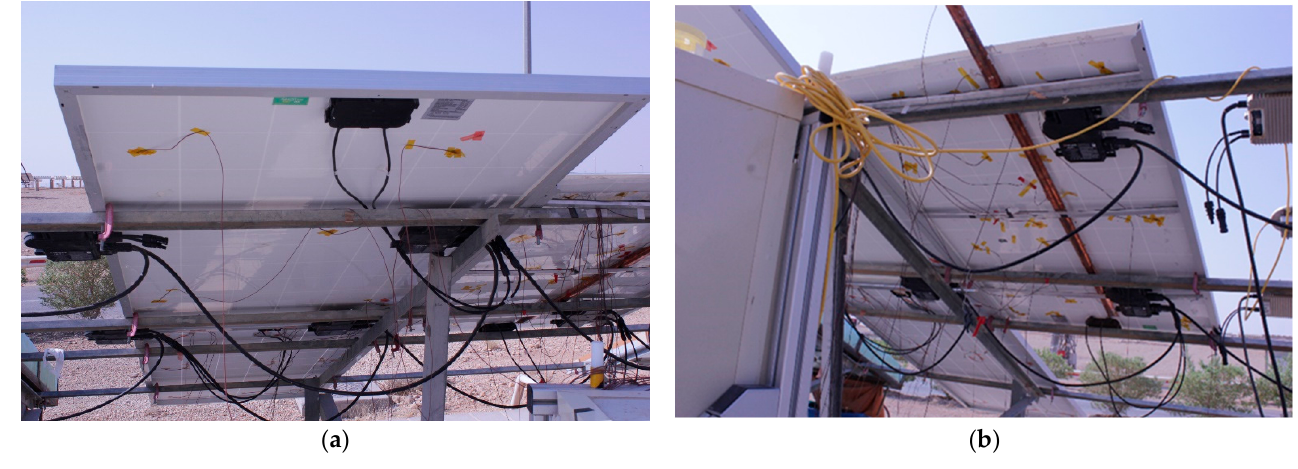
Figure 1. ( a ) Experimental setup, ( b ) HPT’s arrangement.